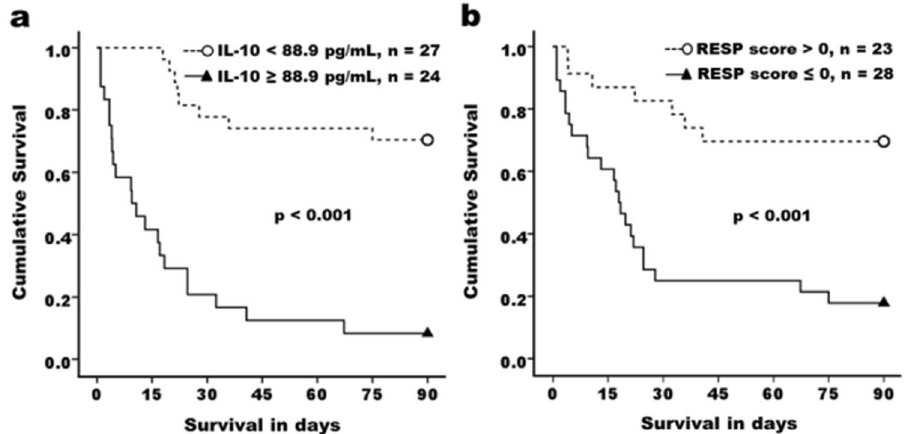
Figure 4. Kaplan–Meier analysis for 90-day survival probability in ARDS patients receiving ECMO support according to initial IL-10 levels and RESP scores. ARDS patients with higher plasma IL-10 levels at day 0 ( a ) and lower RESP scores ( b ) before ECMO implementation were associated with significantly worse survival.